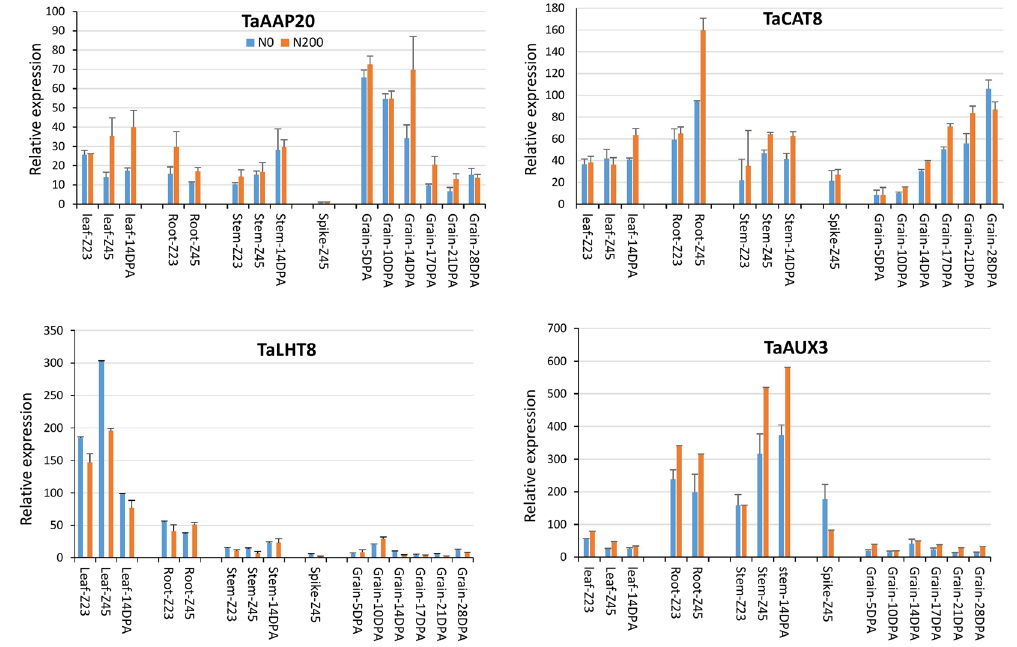
Figure 6. The four AATs representing high expression levels in different organs were confirmed by qPCR under two nitrogen applications at N0 (no nitrogen) and N200 (200 kg/ha nitrogen). Error bars represent standard